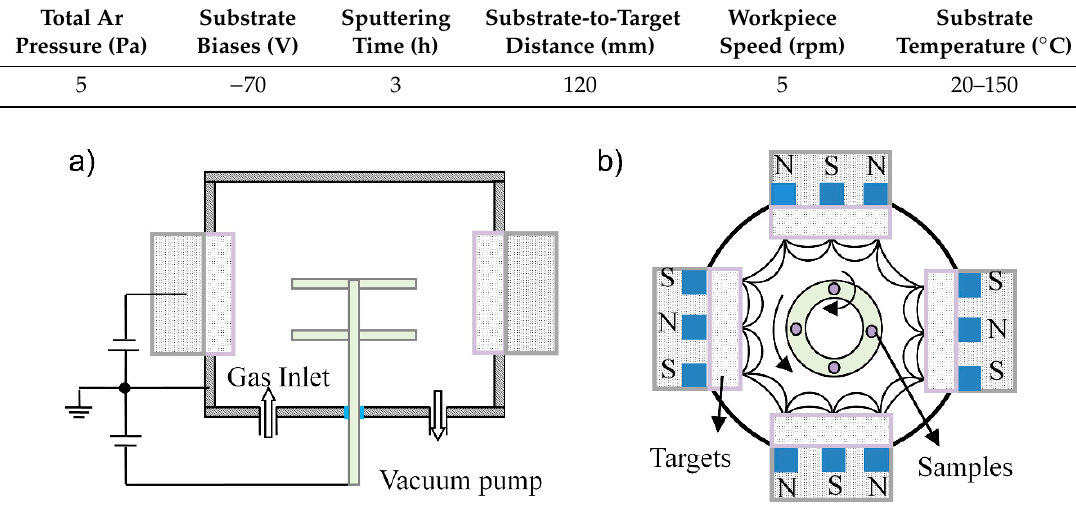
Figure 1. Schematic illustration of the magnetron sputtering system: ( a ) the UDP450 magnetron sputtering equipment, and ( b ) the internal layout. Table 3. The target powers for the fabrication of the film with different Cu and Ti contents.